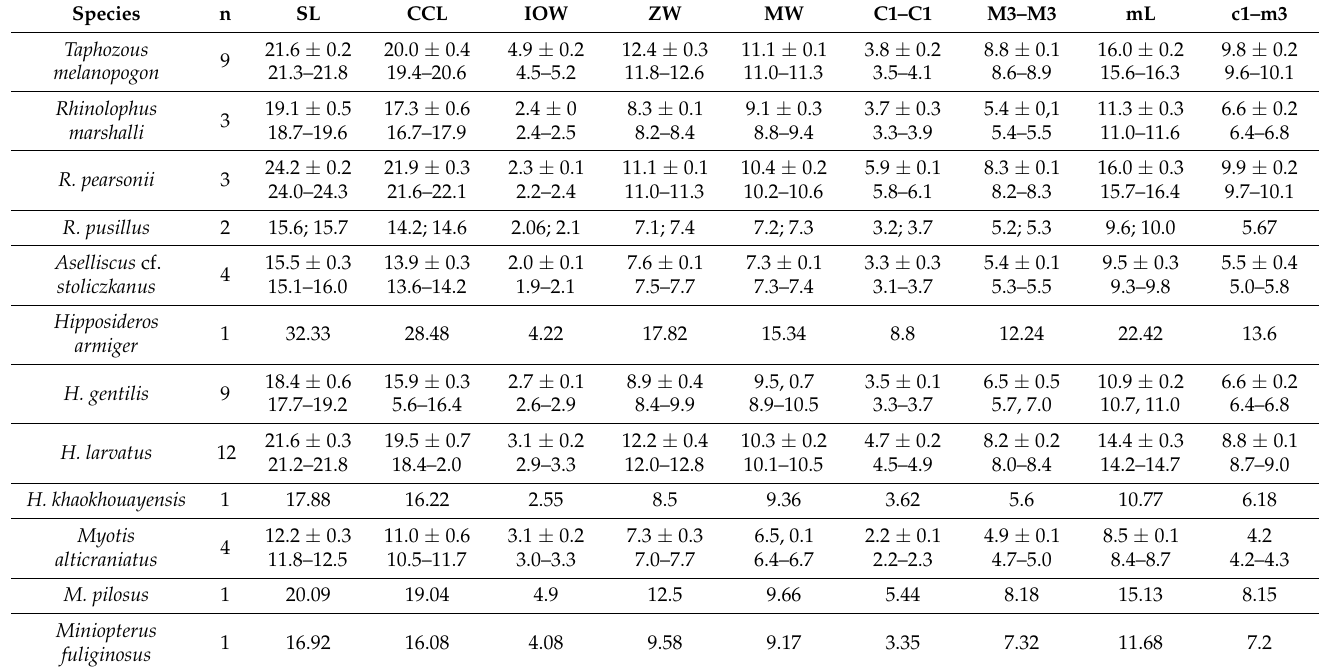
Table 3. Ten craniodental measurements (in mm) of bat species recorded from Cat Ba Biosphere Reserve between 2015 and 2020. Abbreviations are defined in the Material and Methods section. Sample sizes differing from those reported under n are given in paratheses. Data are presented as a range, mean and SD are included when the sample size is ≥